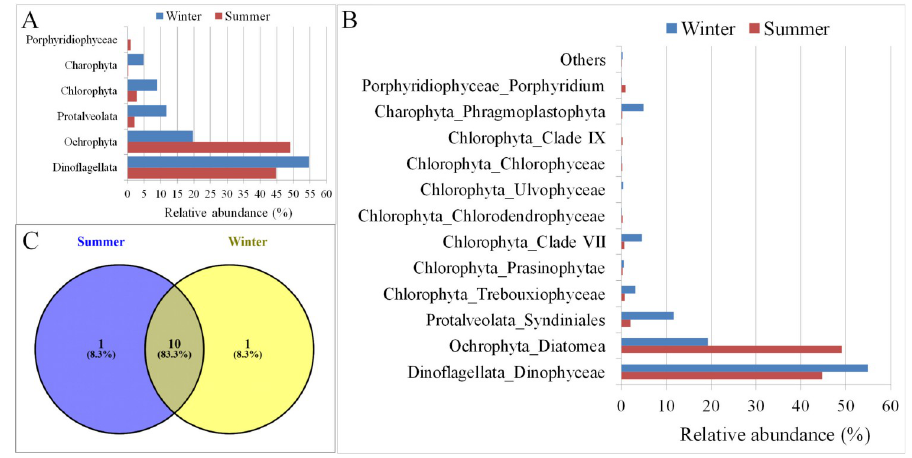
Fig 5. Marine phytoplankton diversity between summer and winter across different sampling stations in Kuwait Waters. A and B: Microalgae groups. C. Shared and unique microalgae groups.